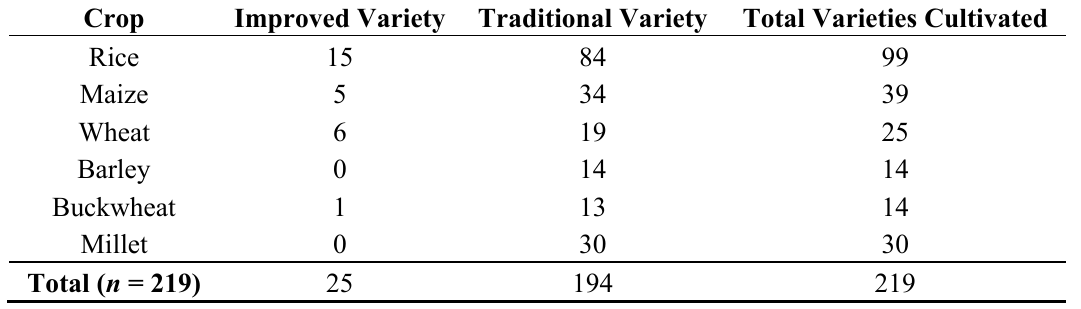
Table 2. Number of improved and traditional varieties cultivated by the interviewed farmers in the study